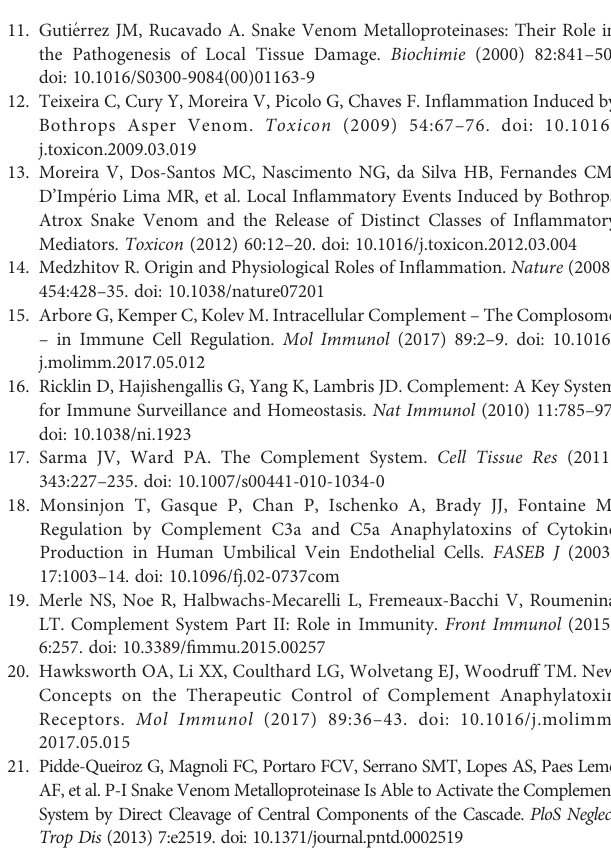
Supplementary Figure 1 | Expression of surface markers in monocytes and granulocytes after treatment with B. jararaca venom. Human blood samples containing GPRP (8 mg/mL) were treated with B . jararaca venom (50 m g/mL) or sterilesalinesolution(negativecontrol)for60minutesat37°C.Afterincubation,cells were analyzed for the expression of C3aR, TLR2 and TLR4. The results are expressed as MFI ± SEM of duplicates from three independent